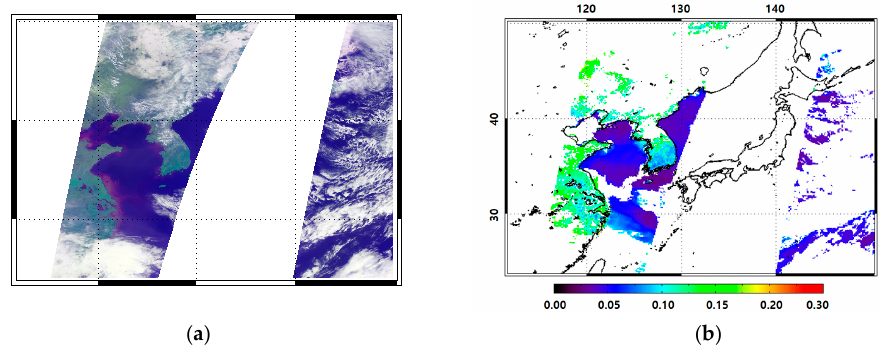
Figure 2. An example of ( a ) the TANSO-CAI false color image and ( b ) the reflectance after masking turbid water regions over Northeast Asia using TANSO-CAI Level 1B data on 10 March 2011.